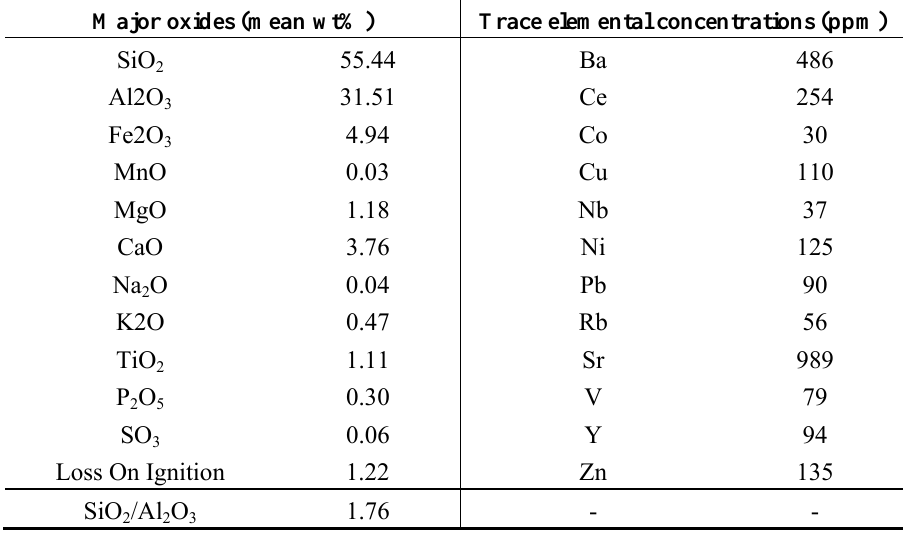
Table 1. X-ray fluorescence results of Arnot coal fly ash composition, illustrating the quantities (wt%) of the major oxides and trace elements